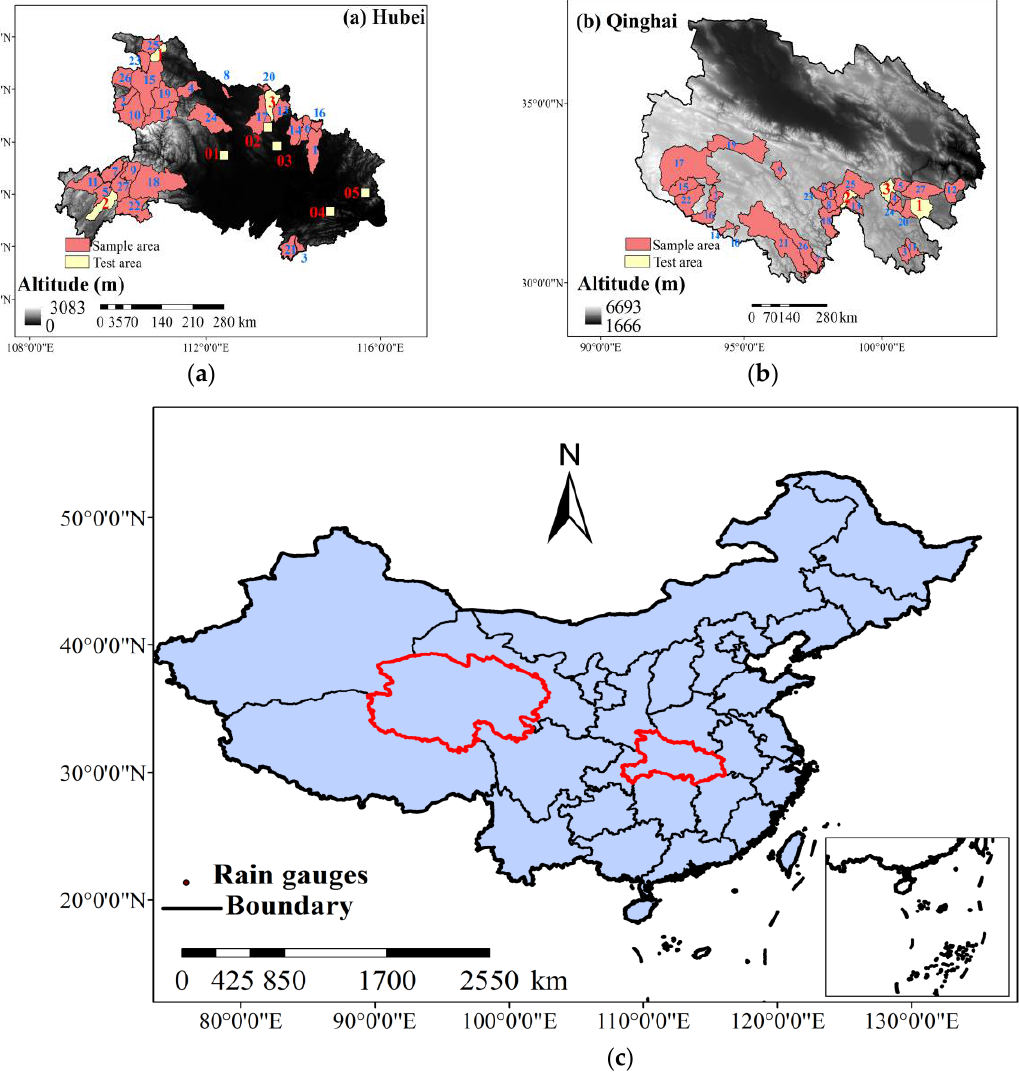
Figure 2. ( a ) Map of Hubei Province depicting 27 sample areas used for model development; ( b ) Map of Qinghai Province depicting 27 sample areas used for model development. ( c ) Map of China with the study areas.